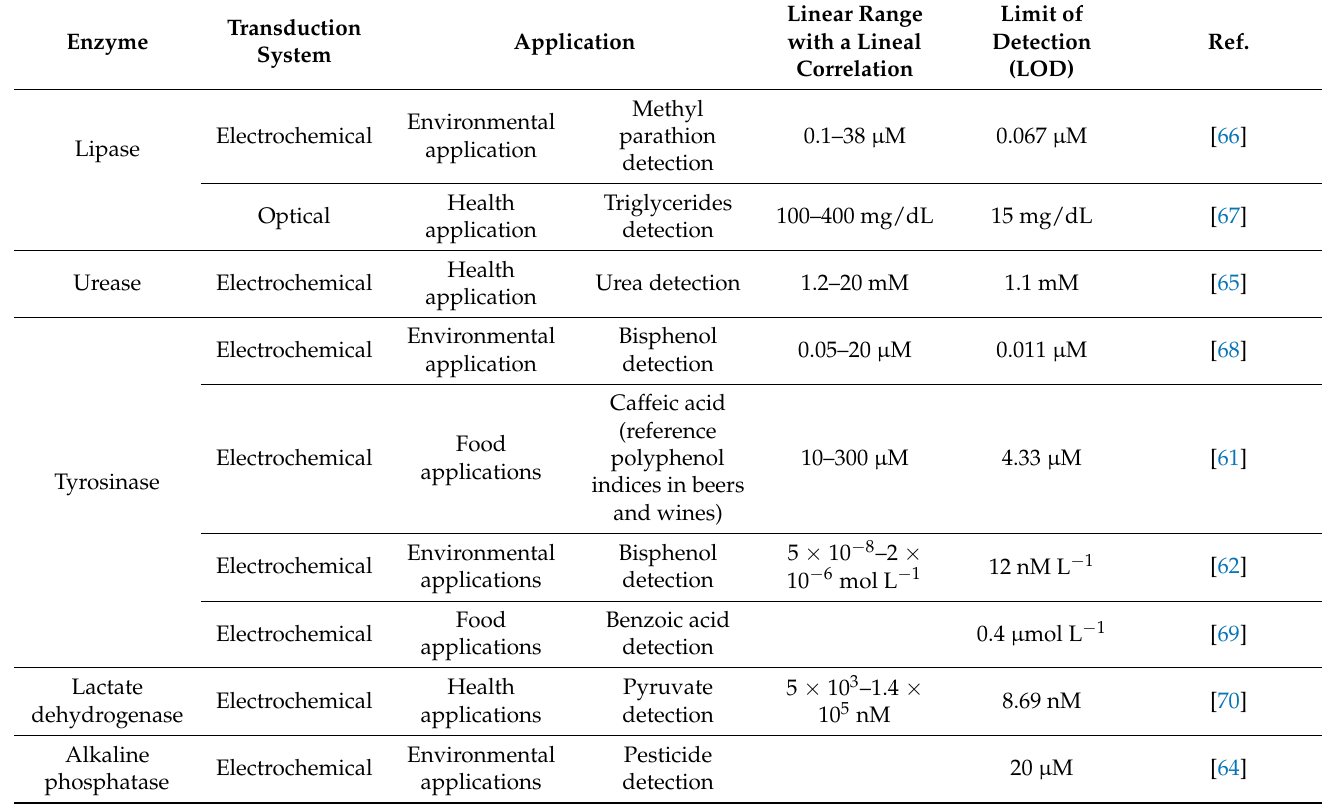
Table 4. Other enzymes commonly used in